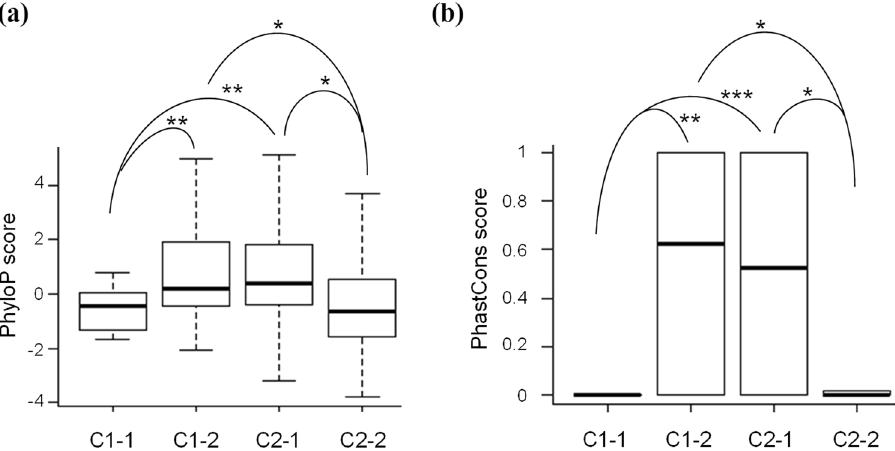
Figure 3. Comparisons of conservation scores measured by ( a ) PhyloP and ( b ) PhastCons for the four categories of ASE sites. The statistical significance was evaluated using the two-tailed Wilcoxon rank sum test (see also Supplemental Table S1). * P < 0.05, ** P < 0.01, *** P <